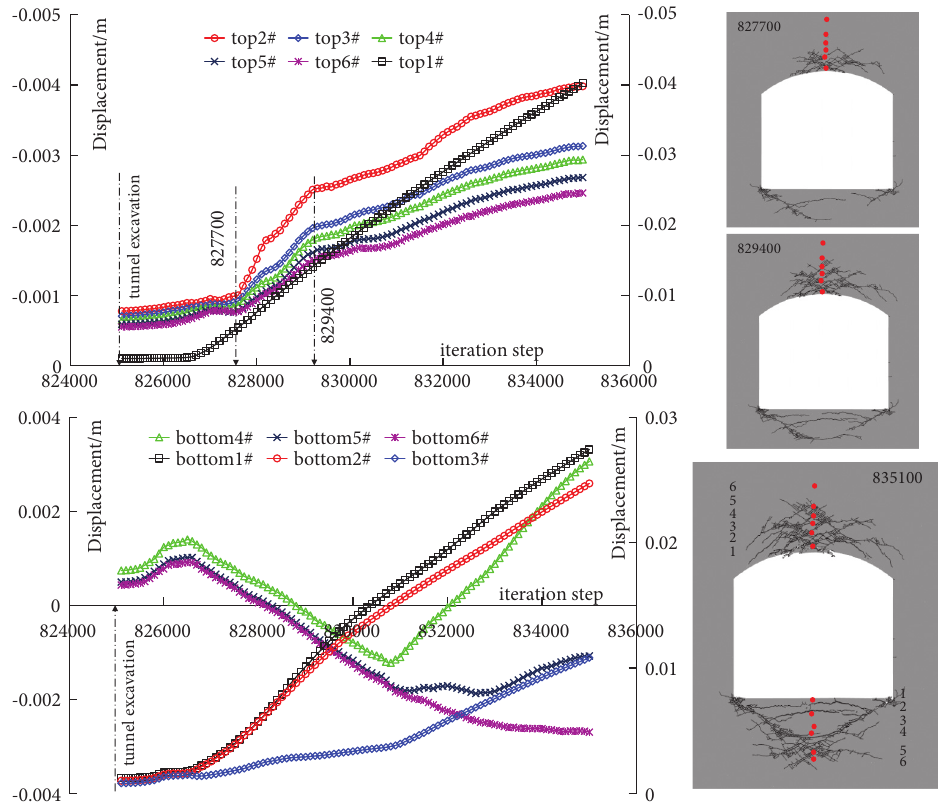
Figure 10: The displacement curve at characteristic points of the surrounding rock